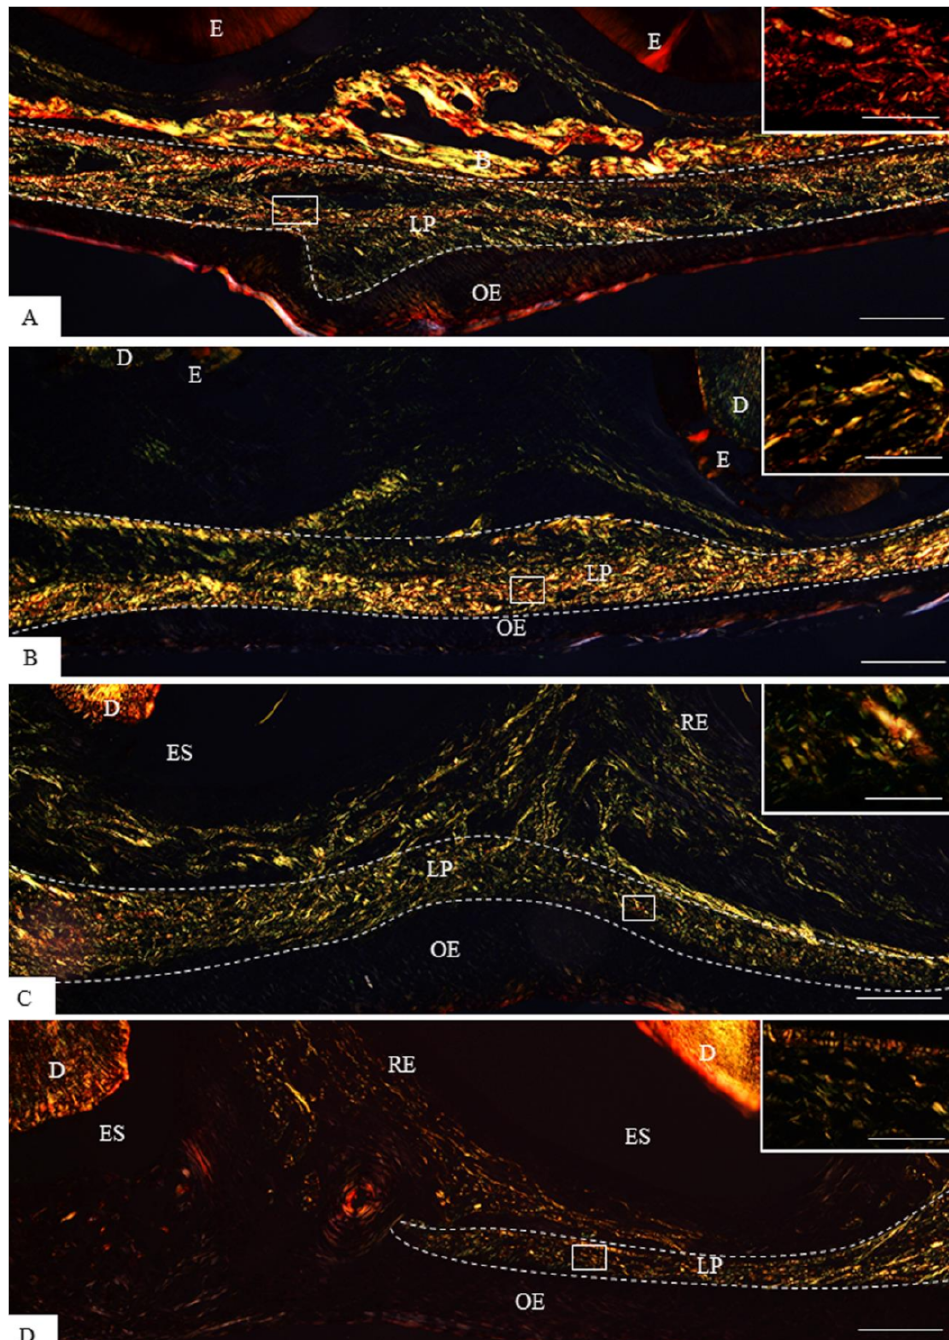
Figure 2. Light micrographs of sagittal sections of maxilla showing portions of the eruptive pathway of the first molar of 9- ( A ), 11- ( B ), 13- ( C ), and 16-day-old ( D ) rats, subjected to the picrosirius-red and analyzed under polarized light. The hatched lines delimit the lamina propria (LP) of the eruptive pathway. Irregularly arranged birefringent collagen fibres are distributed throughout the lamina propria (LP) of 9- ( A ) and 11-day-old ( B ) rats. The lamina propria (LP) contains mainly bundles of birefringent collagen exhibiting red ( A , inset) and yellow ( B , inset) colours. C and D —few birefringent collagen fibres exhibiting the hue varying from yellow to green are present in the lamina propria (LP) of 13- and 16-day-old rats. The insets, outlined areas in C and D , show thin bundles of birefringent collagen fibres. D, dentine; E, enamel matrix; B, bone trabeculae; OE, oral epithelium; RE, reduced enamel epithelium. Bars: 50 µ m and 5 µ m